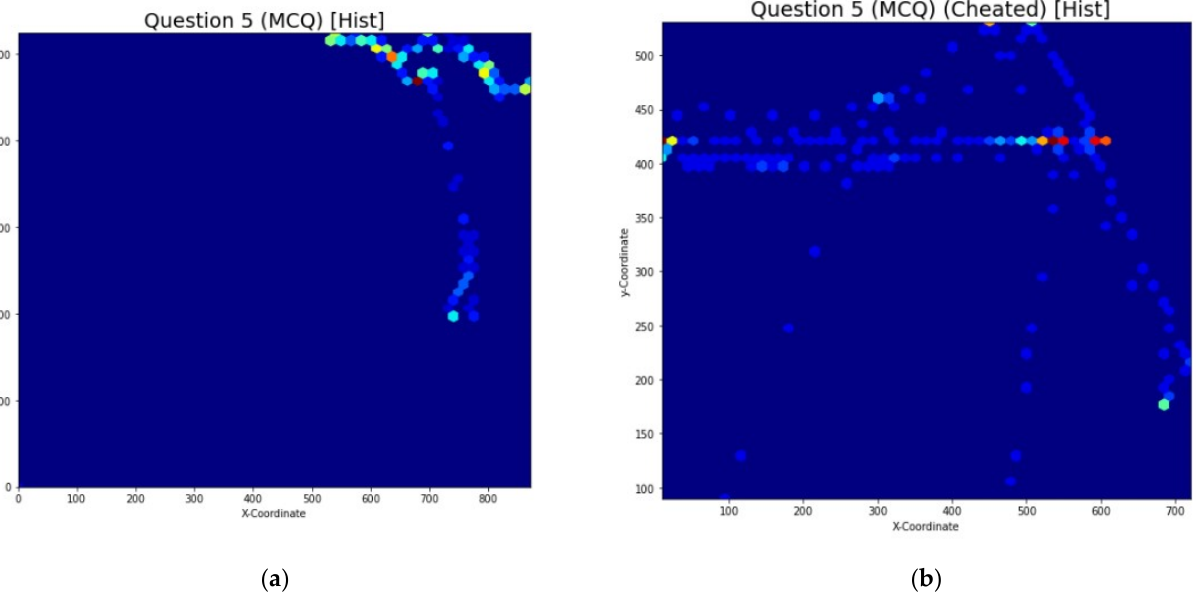
Figure 10. A histogram of raw mouse movements showing the difference in the frequency of movements is as follows: ( a ) a KDE plot of question 5 answered by students without cheating; ( b ) a KDE plot of question 5 answered by students who are allowed to cheat.